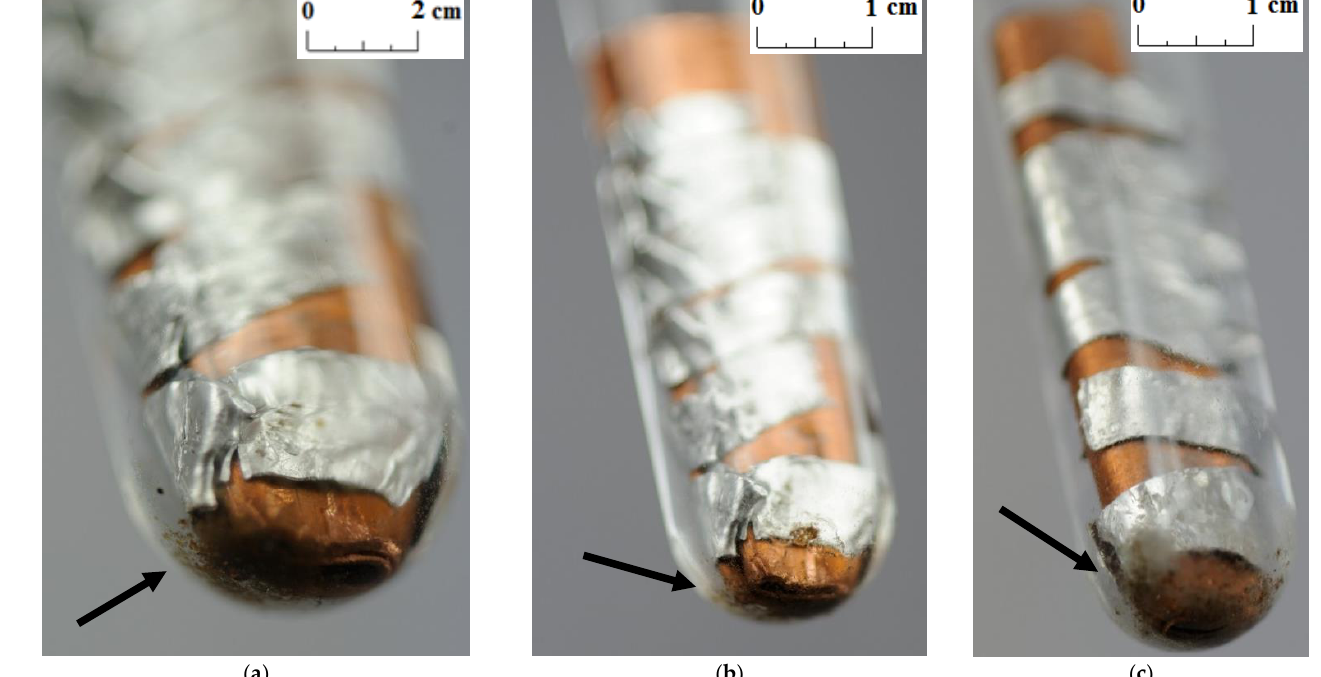
Figure 7. The precipitate which deposited on the sample with a combination of aluminum and copper immersed in RT22 HC; ( a ) after 3 weeks; ( b ) after 4 weeks; and ( c ) after 7 weeks.